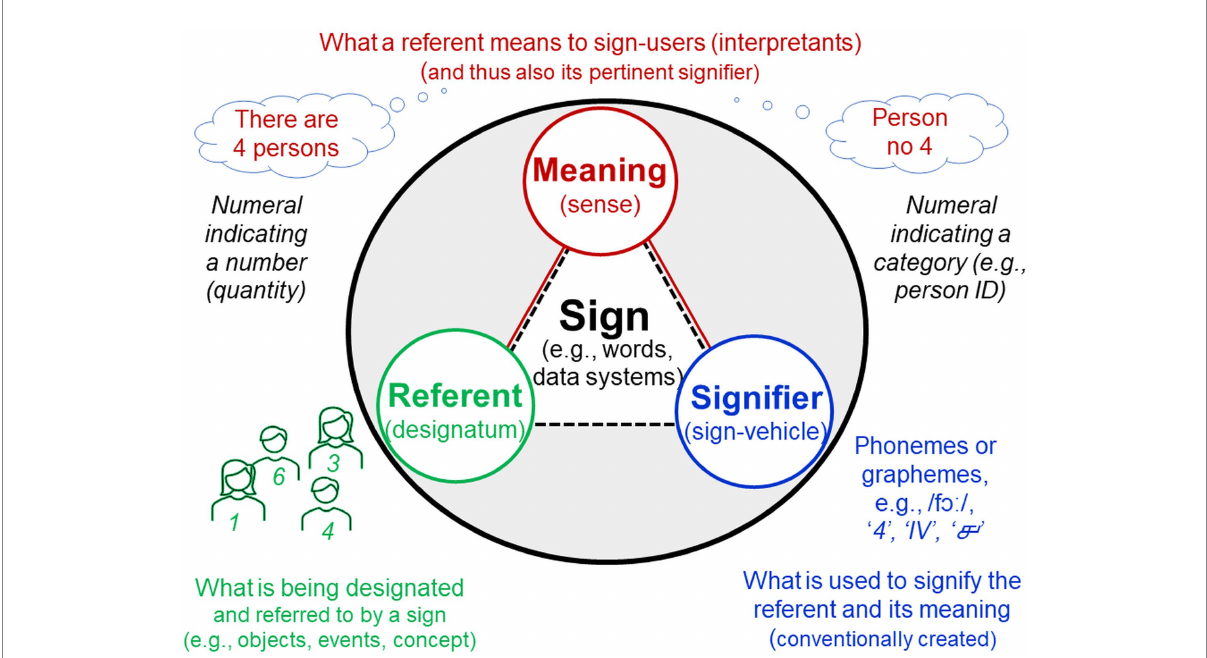
FIGURE 5 The representational function of language and other sign systems. Sign systems comprise three metatheoretical components: signifiers, referents and meanings. Socio-cultural conventions turn publicly accessible (arbitrary) creations ( signifiers ; e.g., phonemes or graphemes) into sign vehicles that can represent objects of consideration ( referents ) and their sense, significance or purpose for someone ( meaning ) even whilst these objects are absent and without any inherent relations to them (e.g.,